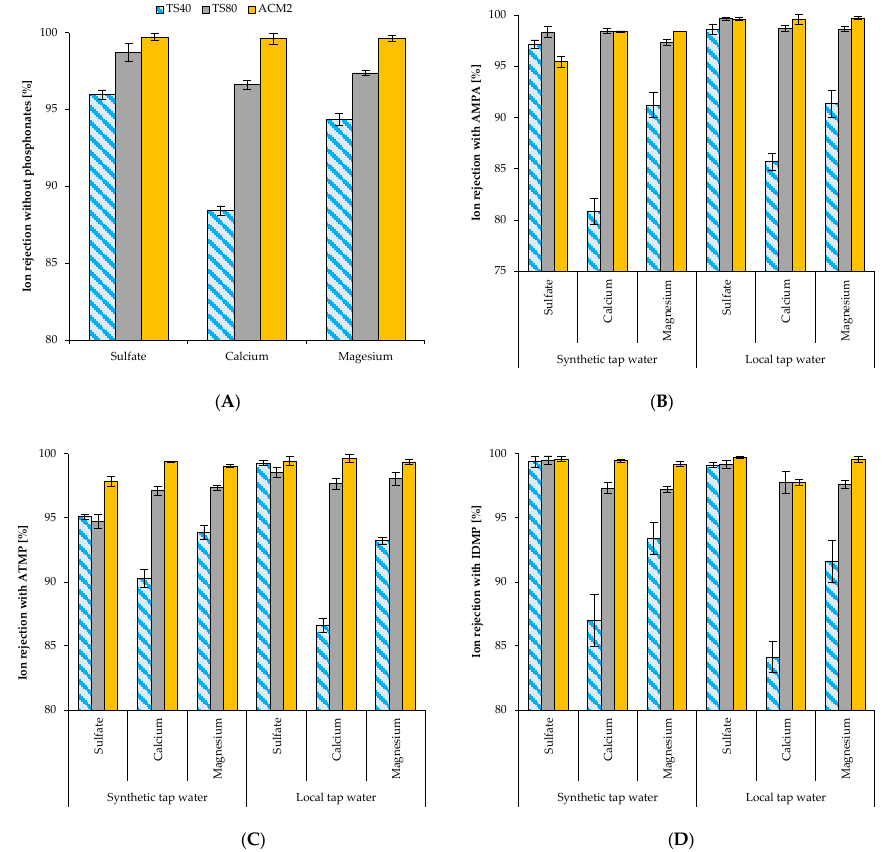
Figure 3. Divalent ion rejections with and without the addition of phosphonate; ( A ) Reference rejection results of tested membranes without phosphonate addition; ( B ) Rejection of divalent ions with 10 mg L − 1 AMPA addition; ( C ) Rejection of divalent ions with 10 mg L − 1 IDMP addition; ( D ) Rejection of divalent ions with 10 mg L − 1 ATMP addition.